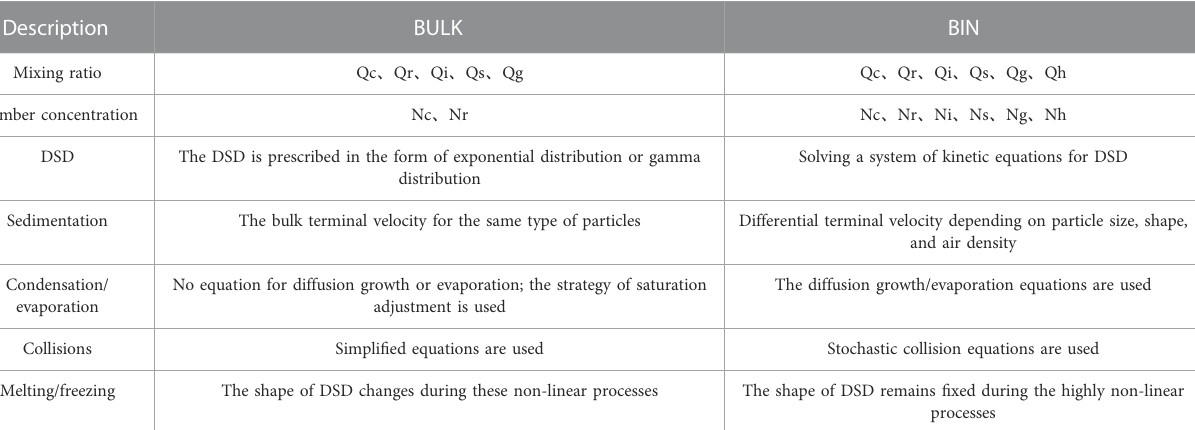
TABLE 2 Differences between BIN and BULK